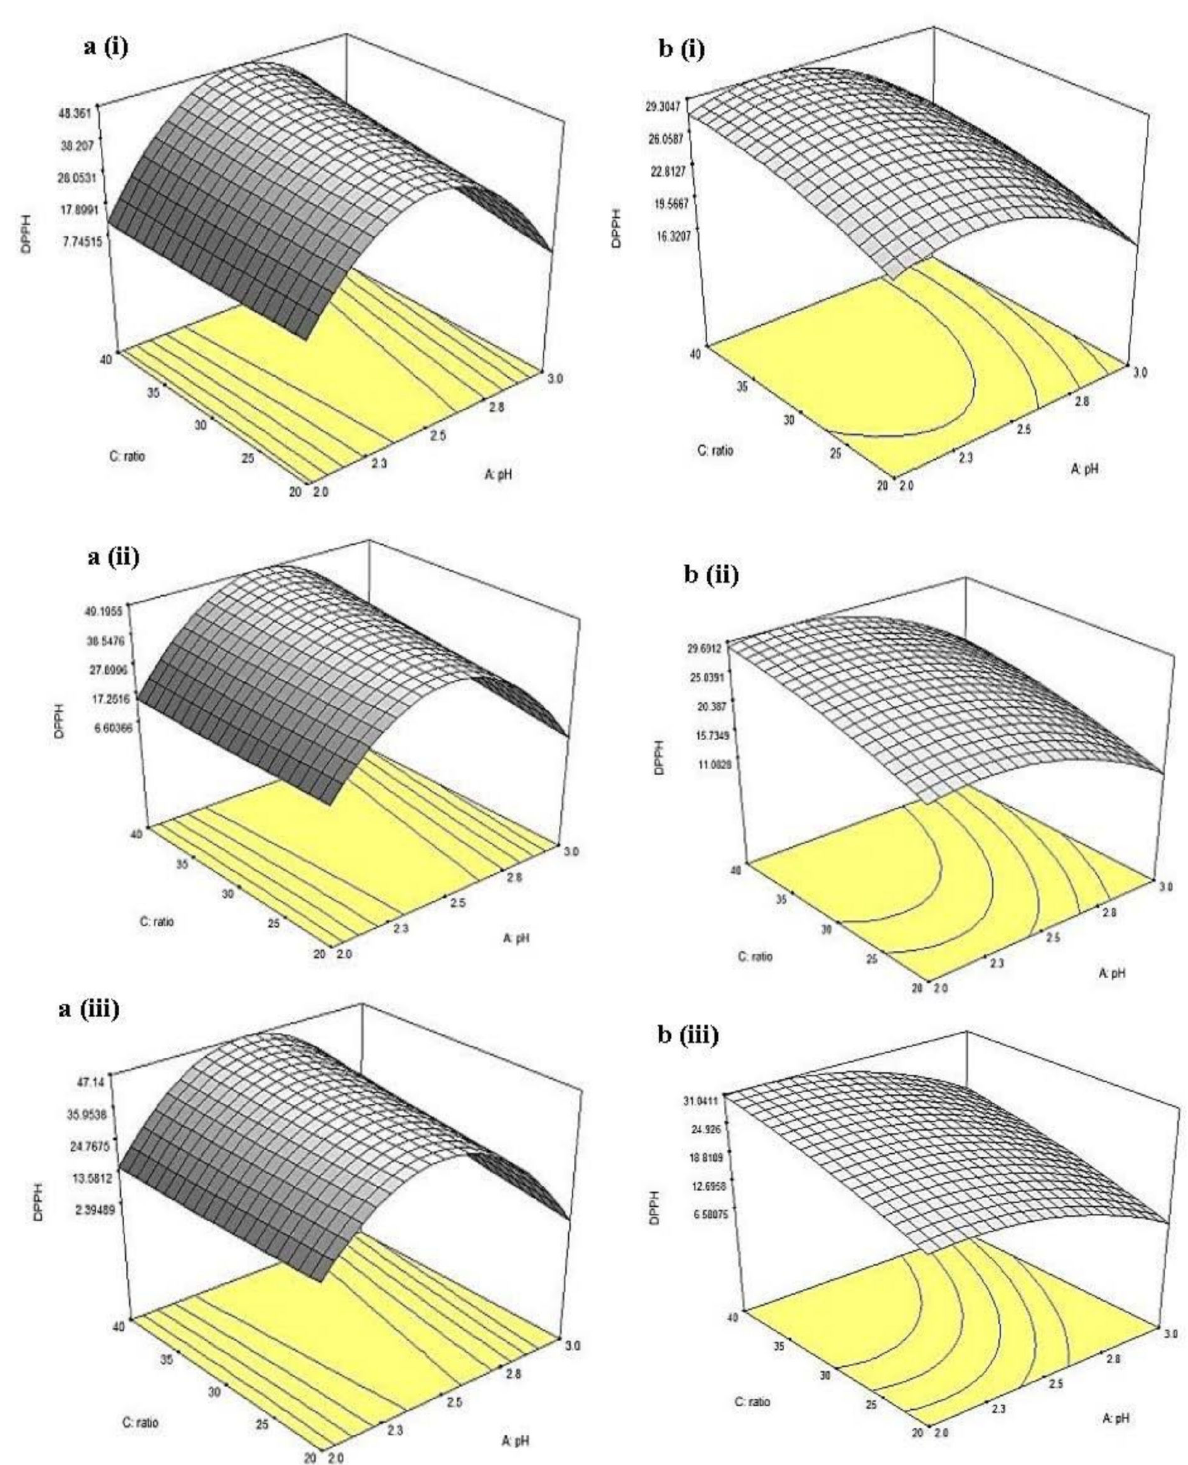
Figure 9. Three-dimensional response surfaces for %DPPH sc of ( a ) China cultivar of lotus root at (i) 0.5, (ii) 1, (iii) 1.5 h extraction time and ( b ) Malaysia cultivar of lotus root at (i) 0.5, (ii) 1, and (iii) 1.5 h extraction time as a function of pH and solvent-to-sample